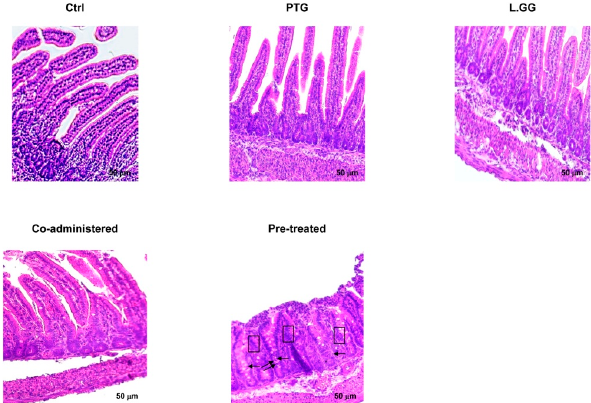
Figure 1. Histology of jejunal tissue sections from control and treated rats, stained with hematoxylin- eosin. Ctrl (without treatment); PTG (sensitized with 1000 U IFN- γ and treated with PTG 50 µ g/day for ten days); L.GG (treated with L.GG 1 × 10 9 CFU for ten days); Co-administered (sensitized with 1000 U IFN- γ and co-administered with PTG and L.GG for ten days); Pre-treated (sensitized with 1000 U IFN- γ , pre-treated with PTG for ten days, and then administered with L.GG for further ten days). Scale bar, 50 µ